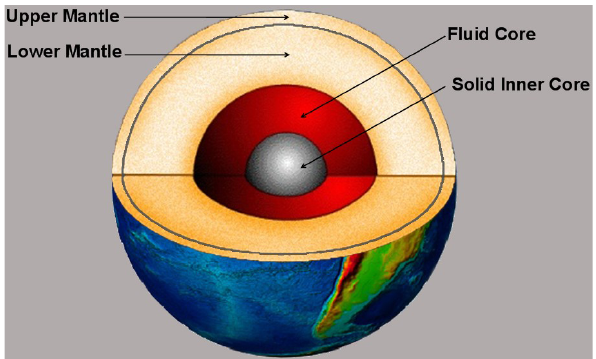
Figure 3. Schematic representation of the major parts of the Earth. From Herndon